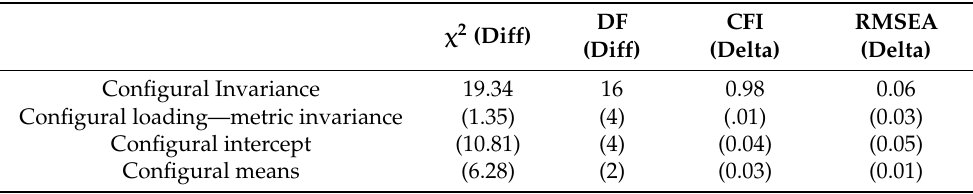
Table 1. Equivalence measurement of SPS6 across countries.